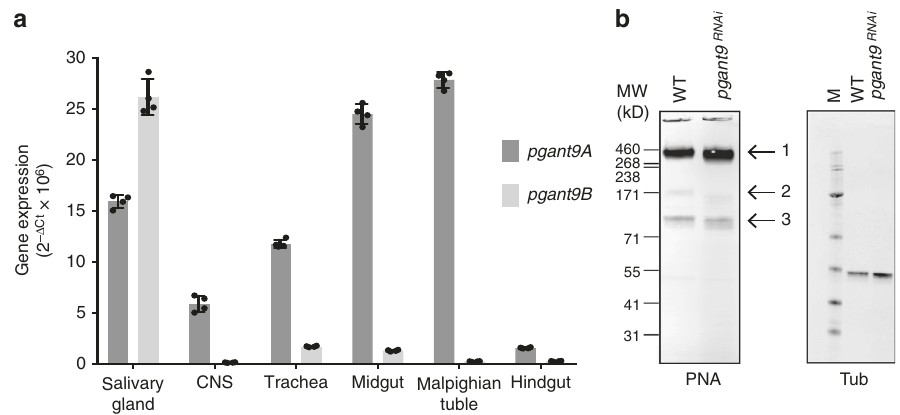
Fig. 3 pgant9 undergoes tissue-speci fi c splicing. a Expression of each splice variant was quantitated in various larval tissues by qPCR. pgant9B expression is most abundant in the salivary gland while pgant9A is the predominant isoform in other tissues examined. RNA levels were normalized to 18S rRNA. Values represent mean ± s.d. from four experiments. b Western blots of salivary gland extracts from WT larvae or larvae expressing RNAi to pgant9 ( pgant9 RNAi ) probed with a lectin (peanut agglutinin; PNA) that detects the major salivary gland O-glycans. Size shifts in the three major PNA-reactive bands are seen (denoted with arrows on the right side of the panel). Tubulin loading control is shown in the lower panel. Representative western blot from four independent experiments are shown. Size markers are shown to the left of each panel